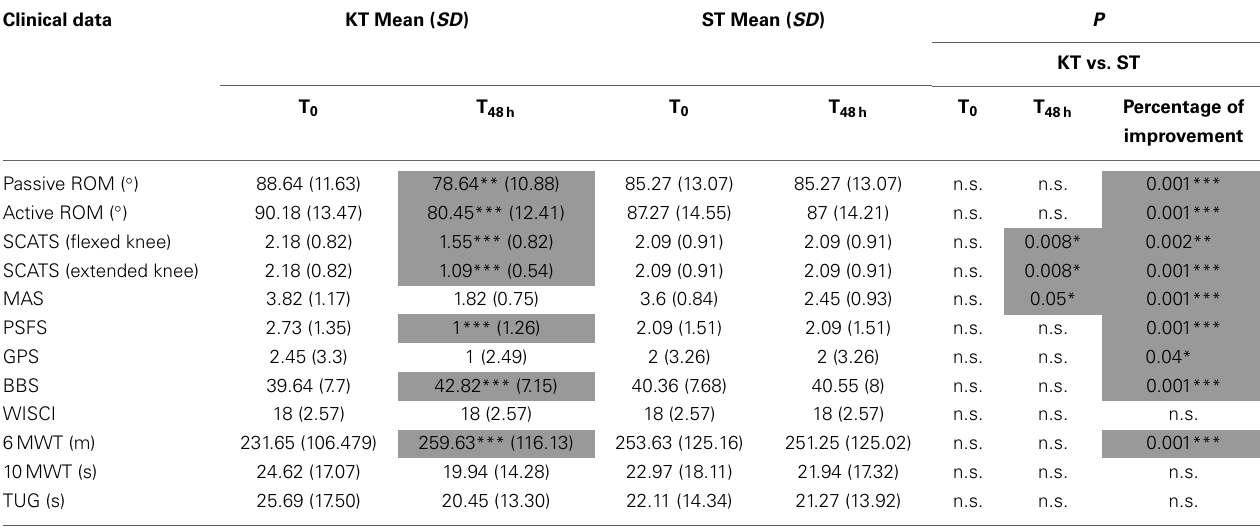
Table 2 | Clinical and instrumental assessment. Clinical